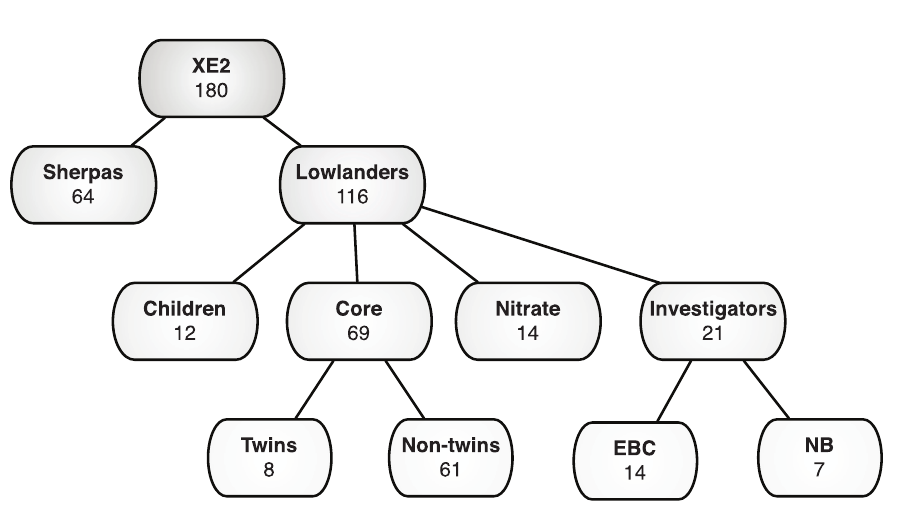
Figure 2. Break down of study cohorts showing number of participants tested. Key: NB = Namche Bazaar, EBC = Everest Base Camp.